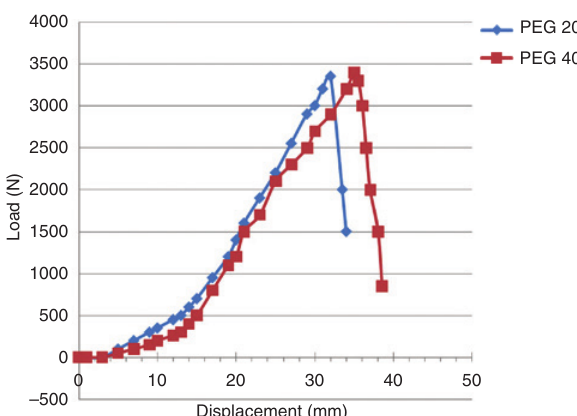
Figure 13: Load-displacement curve for the 30 wt% silica samples in PEG 200 and PEG 400.